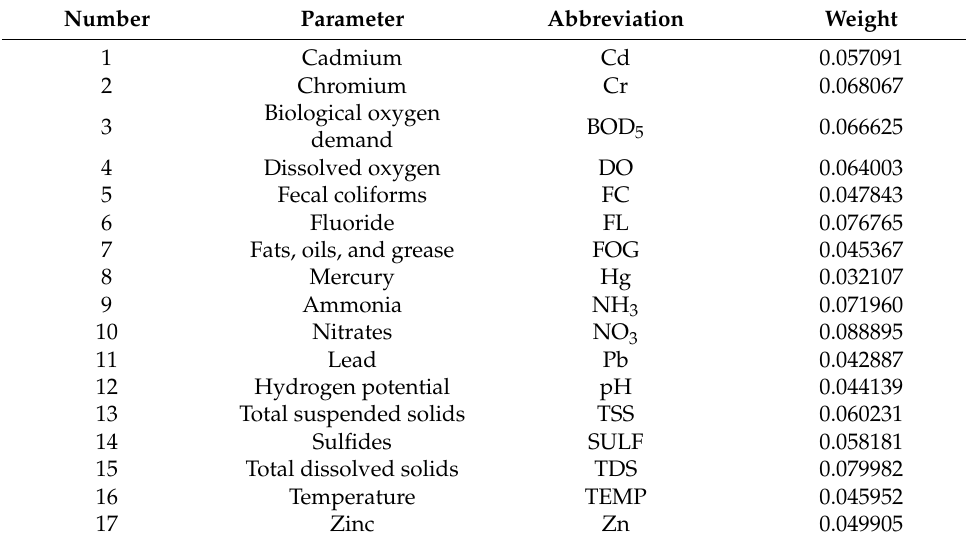
Table 1. Water quality parameters and their assigned weights for the WQI calculation.